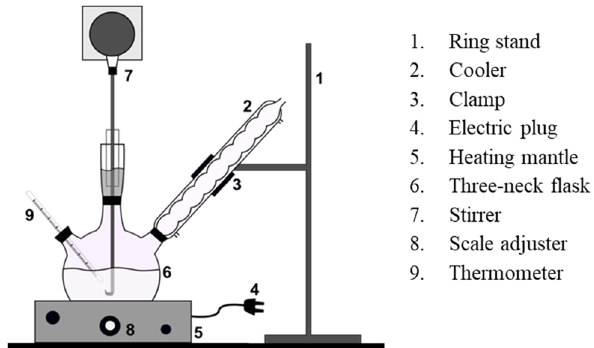
Figure 1: Experimental equipment set [ 33 ]